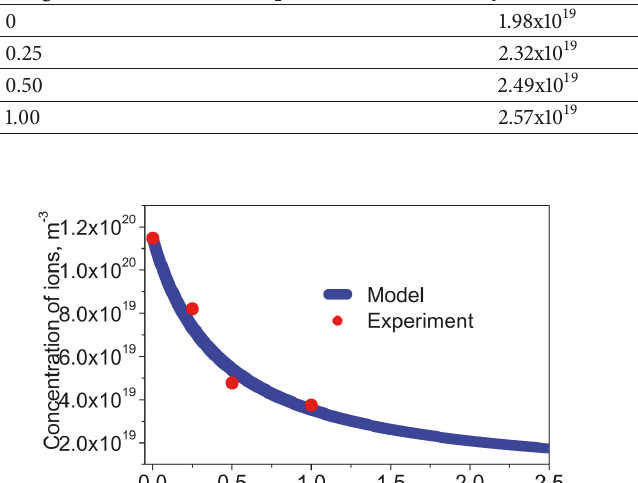
Table 1: The concentration of ionic species in liquid crystals doped with TiO 2 nanoparticles [34]. Weight concentration of TiO , % 2